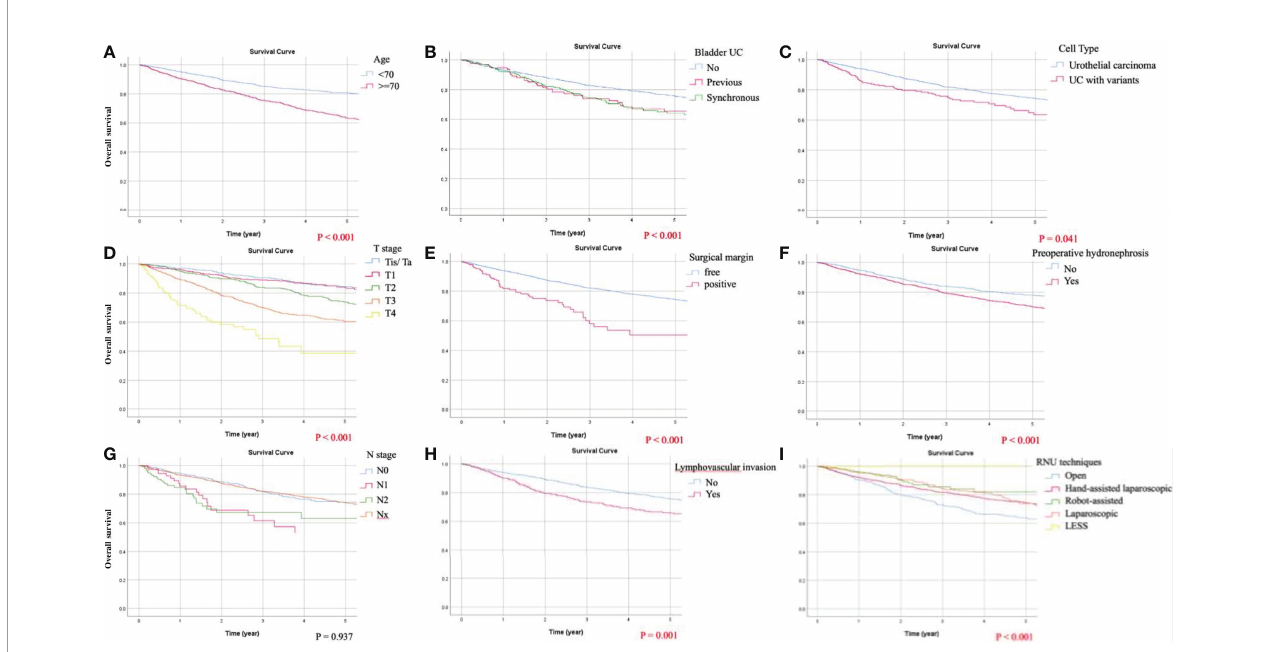
FIGURE 2 | Kaplan-Meier curves of overall survival (OS) following adjustment for age, tumor size, preoperative hydronephrosis, distal ureteral or bladder cuff urothelial carcinoma (UC), multifocal UCs, previous or synchronous bladder UC, lymphovascular invasion (LVI), tumor necrosis, surgical margin, tumor grading, cell type, pathological T and N staging, and surgical approaches of radical nephroureterectomy (RNU). Signi fi cant predicting factors for OS included: (A) age, (B) chronological history of bladder UC, (C) cell type, (D) T stage, (E) surgical margin, (F) preoperative hydronephrosis, (H) LVI, and (I) RNU techniques. (G) N staging did not demonstrate signi fi cant in fl uence on OS because the proportion of lymphadenectomy was limited in the present